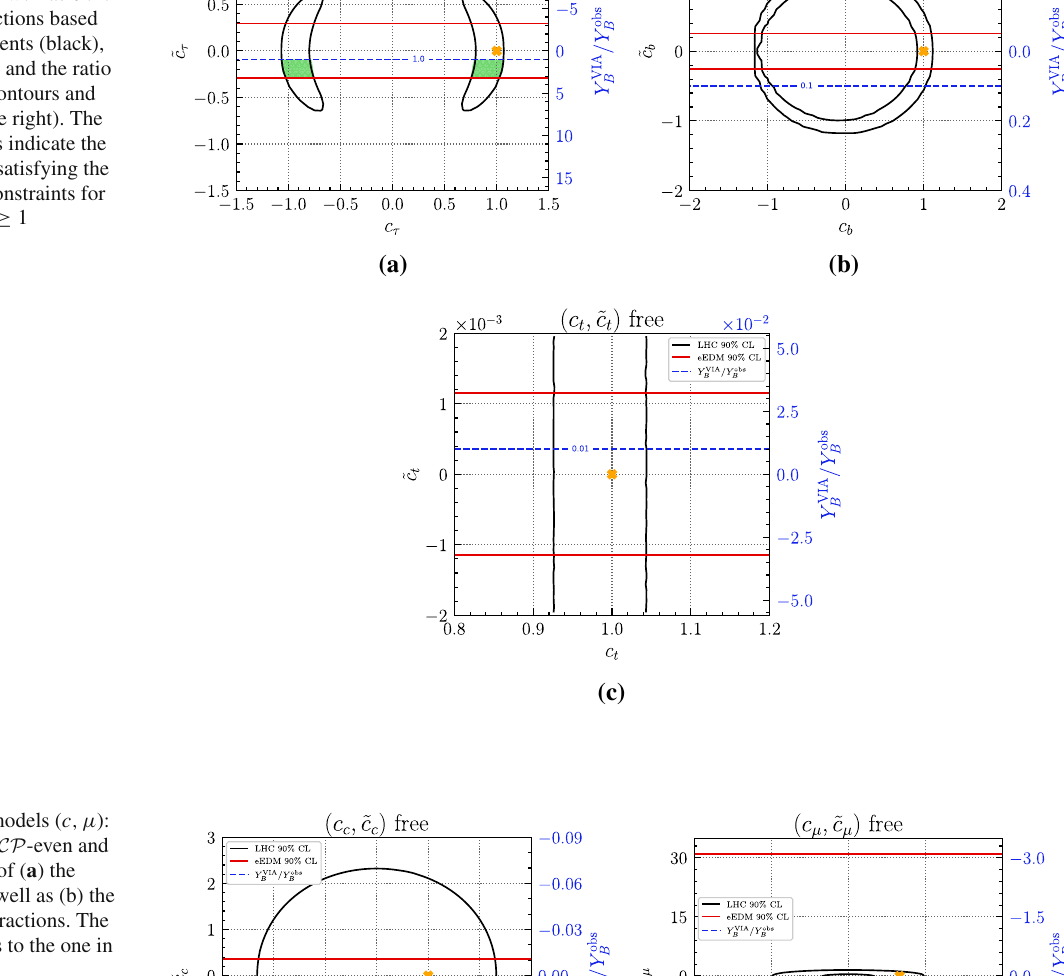
Fig. 10 1-flavor models ( c ,μ ): Constraints on the CP -even and CP -odd modifiers of ( a ) the charm-Yukawa as well as (b) the muon-Yukawa interactions. The legend corresponds to the one in Fig. 9